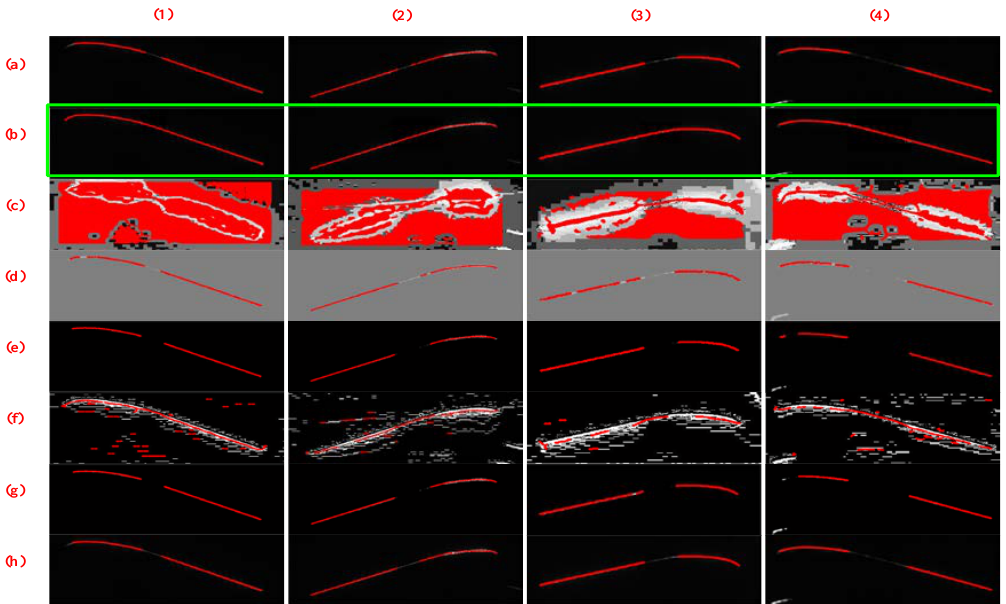
Figure 15. Center extraction results of outer stripe images based on different methods. Columns ( 1 )–( 4 ) present the tread segments with different missing percentages. Row ( a ) shows the raw images. Rows ( b – h ) display the center extraction results of images through HE, CA, LT, CF, MF, and SO methods, respectively, and row ( b ) exhibits the center extraction results of images processed through the proposed method. Sensors 2018 , 18 , x FOR PEER REVIEW 16 of 20